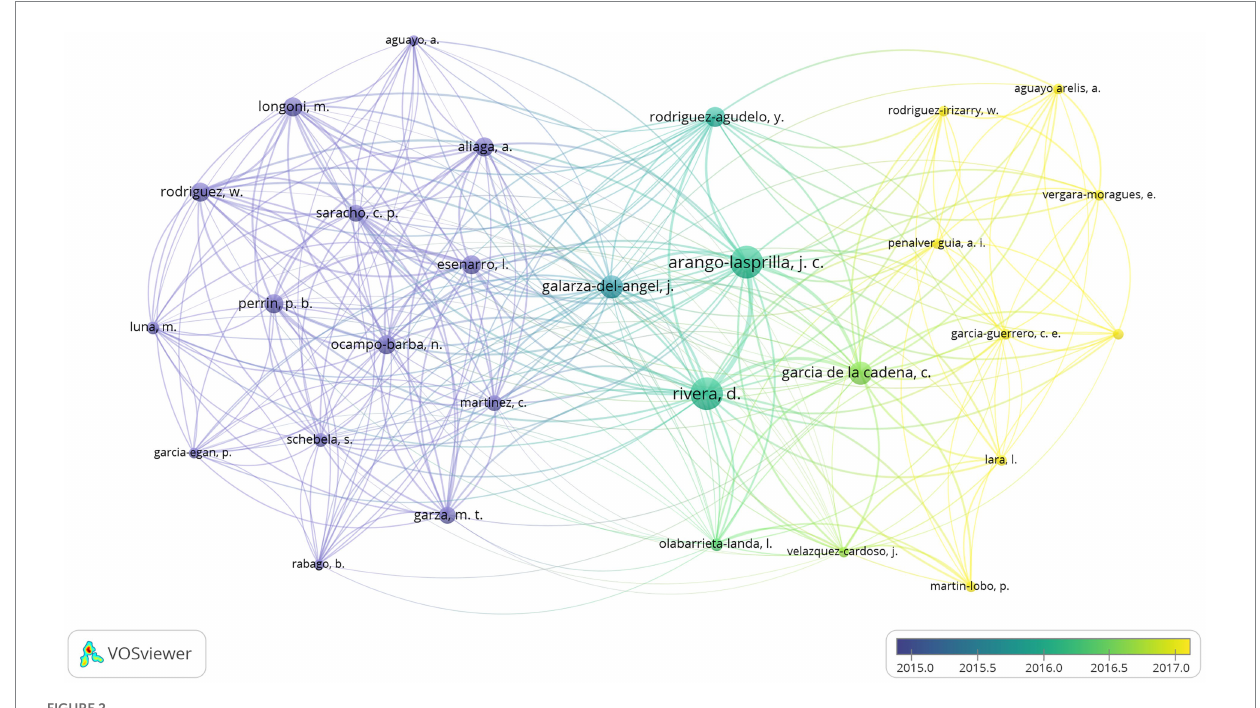
FIGURE 2 The over-lay map of co-authors in Physiology teaching reforms.